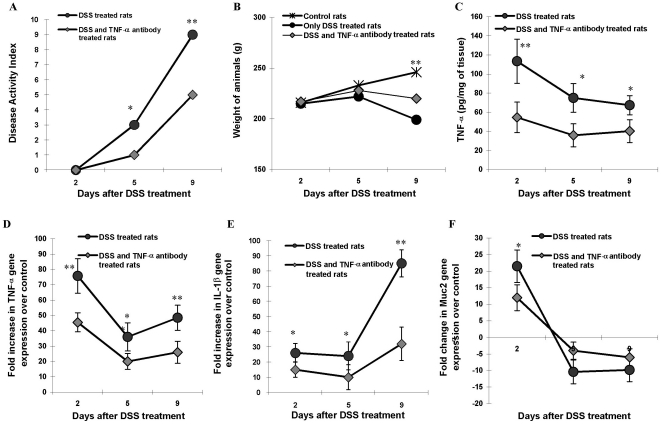
The effect of TNF-α neutralizing antibody treatment on disease onset and progression in DSS induced colitis.
A: Comparison of disease activity index (DAI) on day 2, 5 and 9 of DSS treatment in animals that received 5% DSS in drinking water alone (black circles) or with TNF-α neutralizing antibody (grey diamonds). B: Body weight change plotted for control (asterisks), DSS only (black circles) or DSS + TNF-α neutralizing antibody treatment (grey diamonds). Data represents the means ± SEM from 6 animals per day. C: TNF-α protein secretion measured by ELISA on days 2, 5 and 9 of DSS treatment in animals that received 5% DSS in drinking water alone (black circles) or with TNF-α neutralizing antibody (grey diamonds). Data shown are the means ± SEM of 6-animals/day. *P<0.05 and **P<0.001 compared to control colon. D–F: The relative gene expression levels determined by real time PCR for TNF-α (D), IL-1β (E) and Muc2 (F) genes on day 2, 5 and 9 of DSS treatment in animals that received 5% DSS in drinking water alone (black circles) or with TNF-α neutralizing antibody (grey diamonds). The expression levels of all genes were normalized using GAPDH as housekeeping gene and mRNA levels are as fold change over control. Data shown are the means ± SEM of 6-animals/day. *P<0.05 and **P<0.001 compared to control colon.